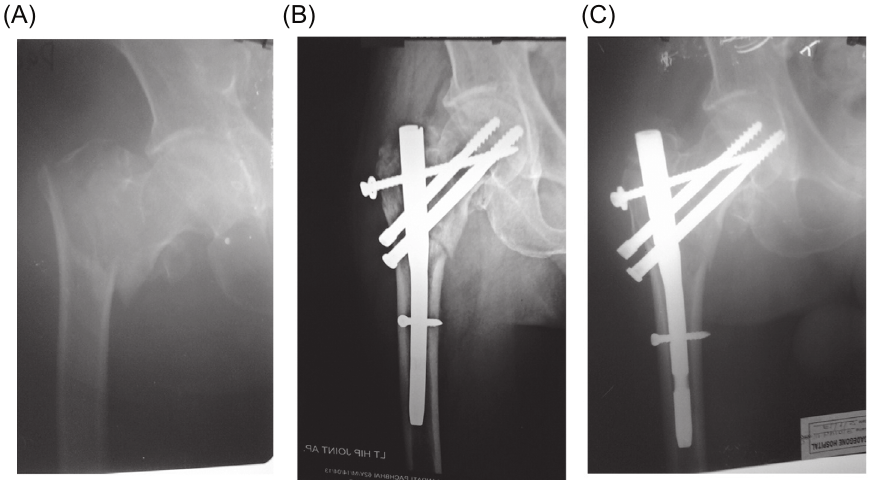
Figure 4. A 75-year-old male. (A) The initial preoperative radiographs. (B) Radiograph six weeks postoperatively with additional screw with washer. (C) Anteroposterior radiograph at 10 months postoperatively demonstrating the fracture